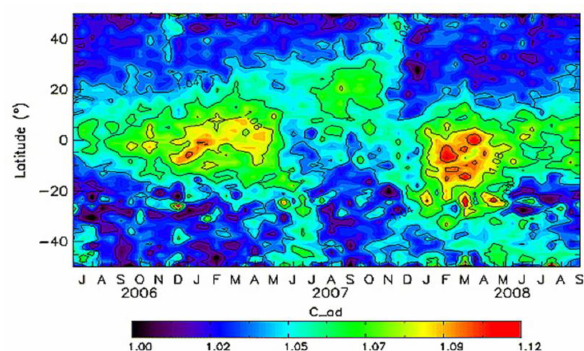
Figure 1. Zonally averaged time–latitude cross section of the ad- justed calibration coefficient obtained using the CALIOP version 2 data (reproduced from Vernier et al., 2009; copyright 2009 by the American Geophysical Union, with permission from John Wiley and